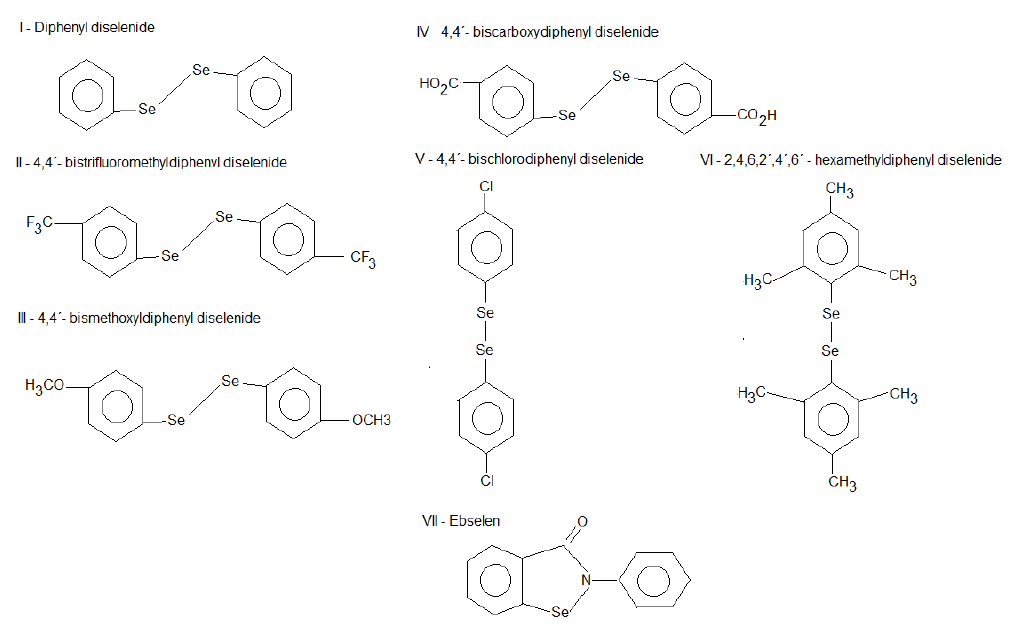
Figure 1. Structures of diselenide